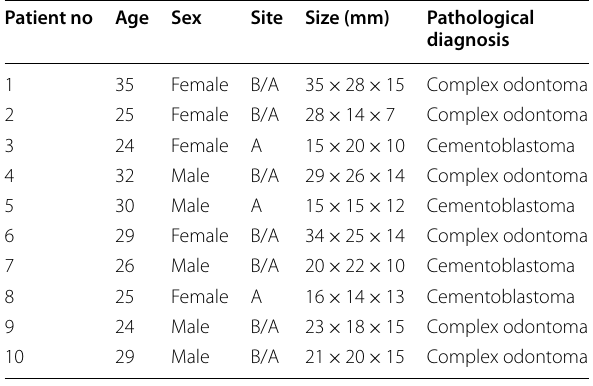
Table 1 Showing demographic data and medical information